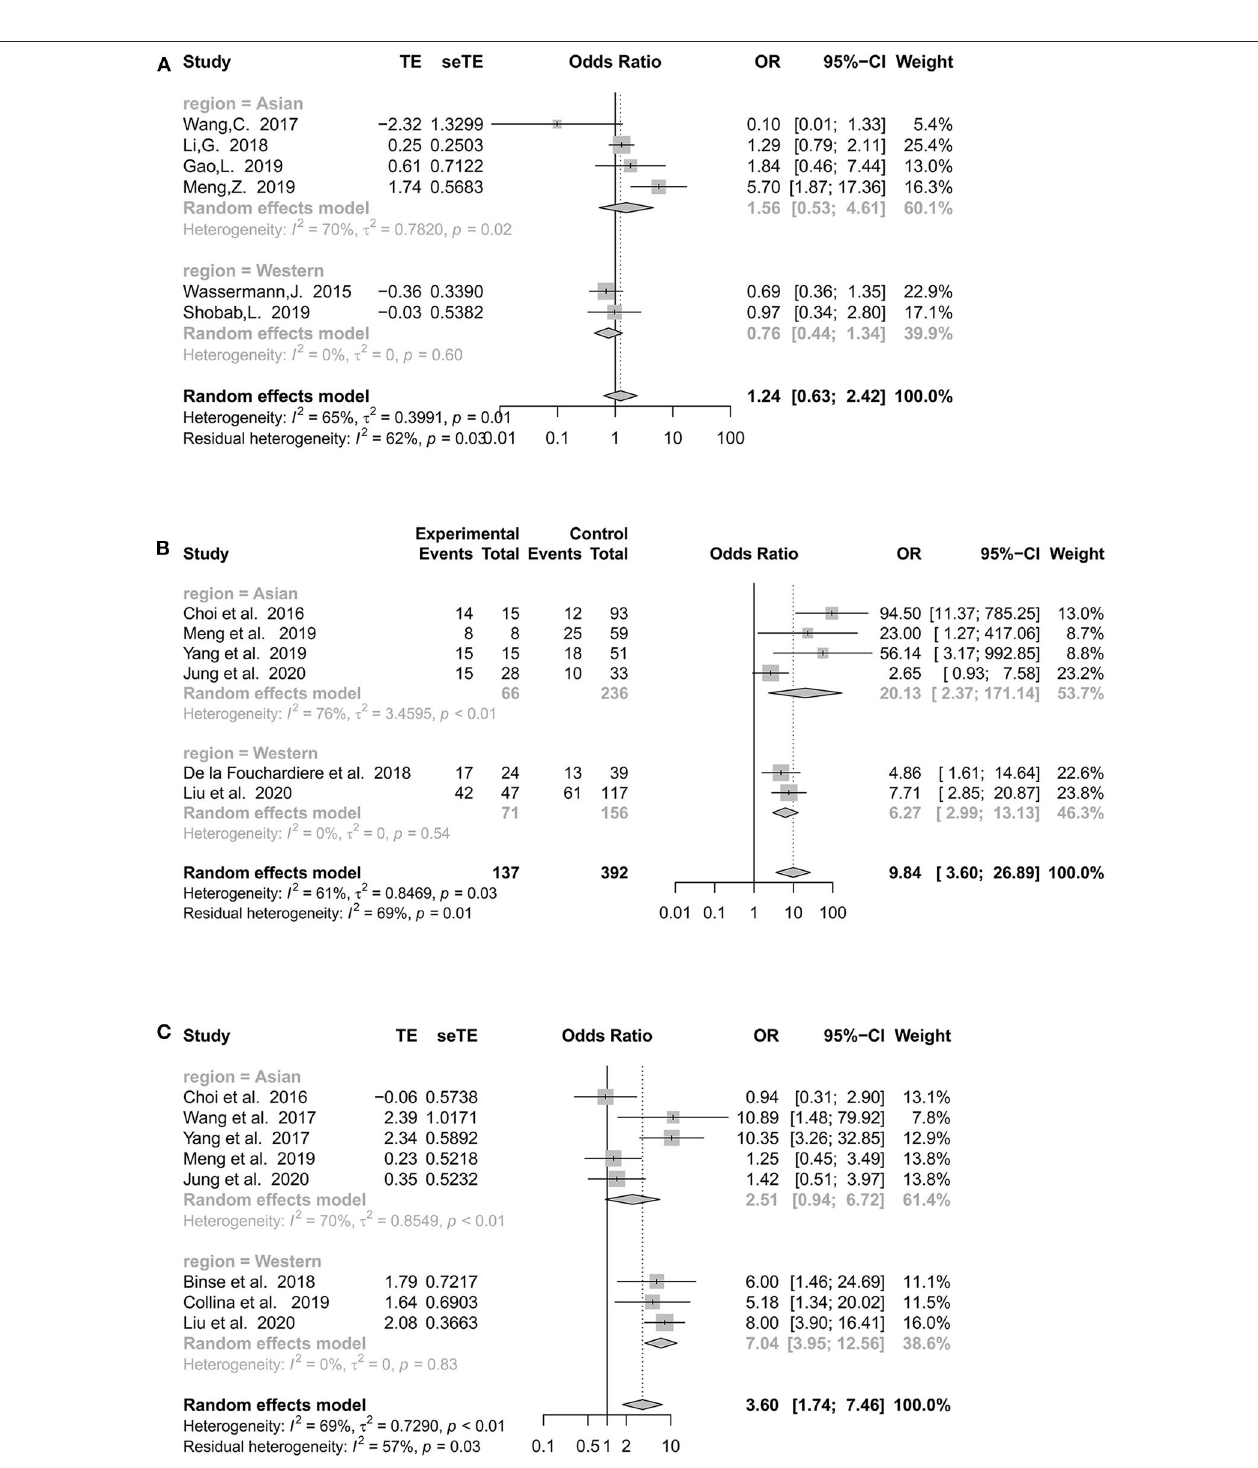
FIGURE 4 | Forest plot detailing the odds ratios with 95% confidence intervals for the effect of multifocality (A) , TERT promoter mutation (B) , and BRAF V 600 E mutation (C) according to different regions.